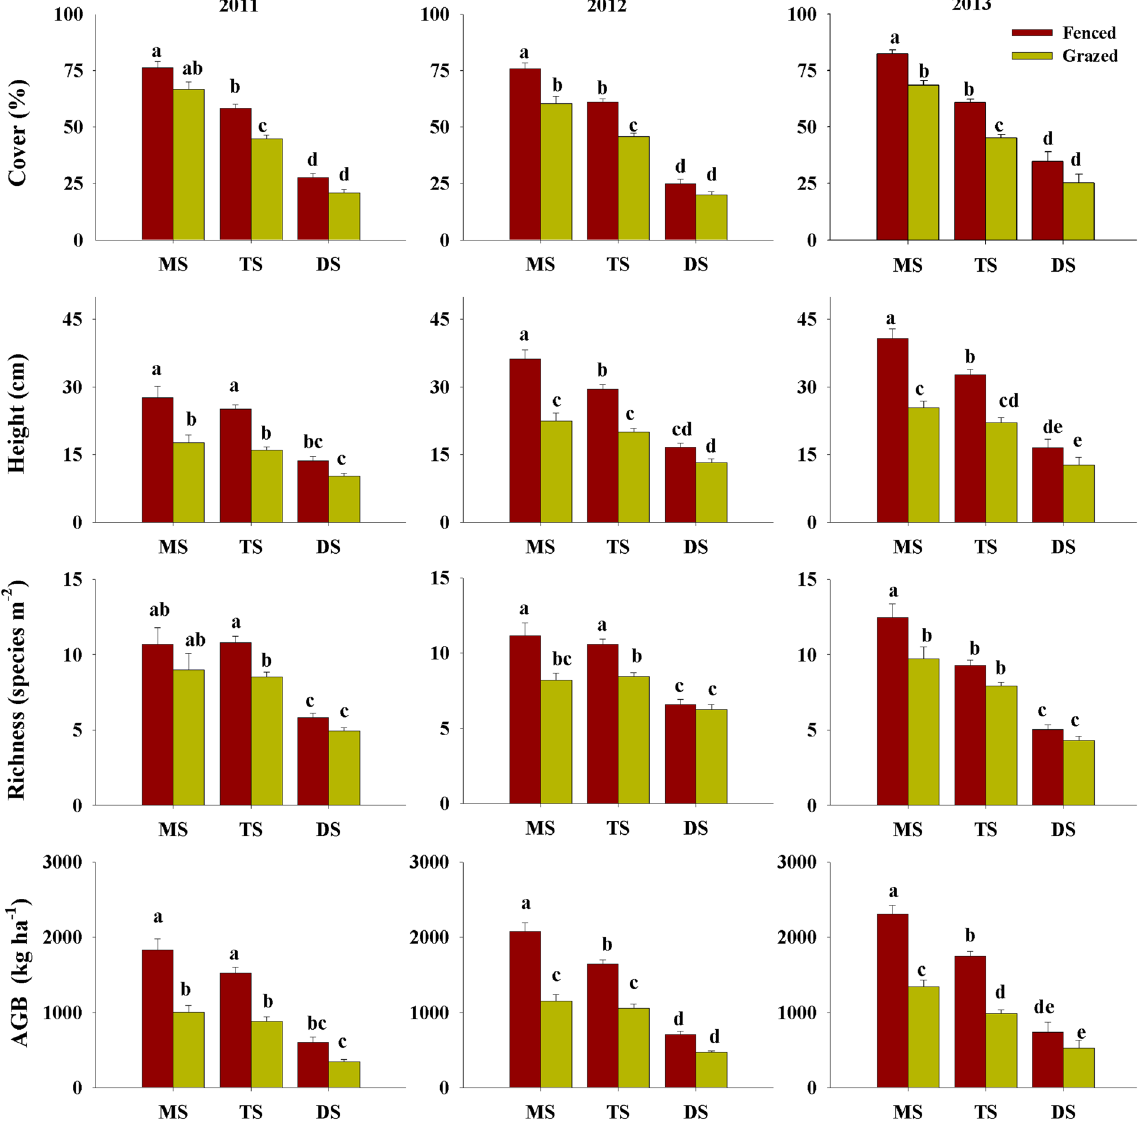
Figure 2. Variation in vegetation cover, height, richness and aboveground biomass (AGB) among three vegetation types (MS: meadow steppe; TS: typical steppe; DS: desert steppe) in